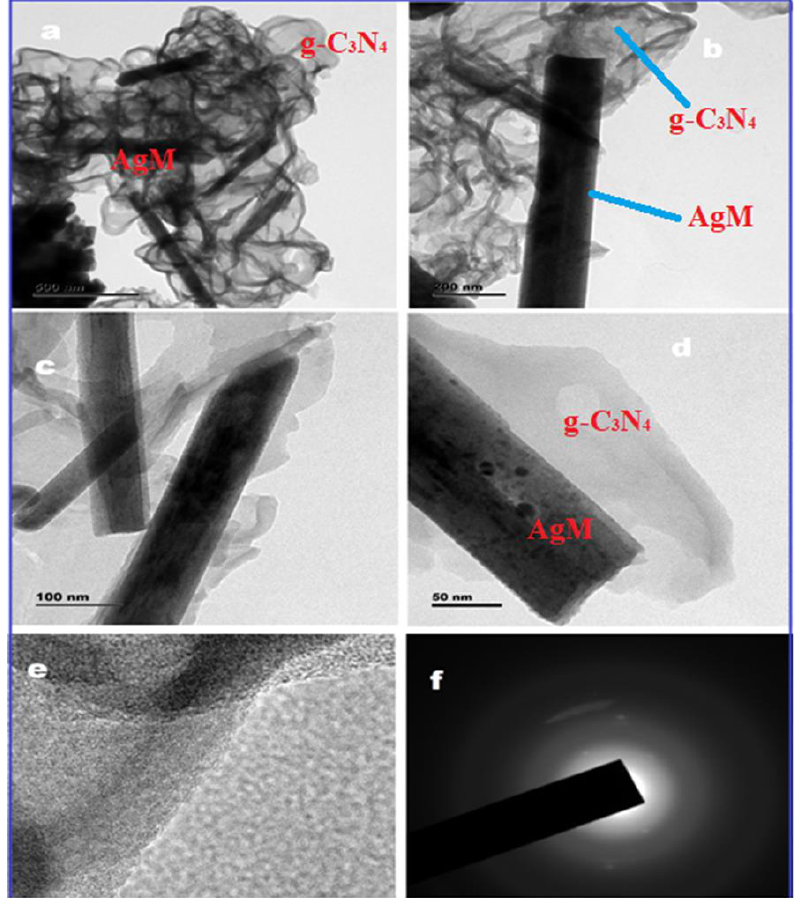
Figure 3. High resolution-transmission electron microscopy (HR-TEM)showing different magnifi- cation images of g-C 3 N 4 /AgM nanocomposites ( a – e ) and selected area electron diffraction (SAED) pattern of g-C 3 N 4 /AgM nanocomposite ( f ) (reproduced with permission from [89], copyright 2020 Elsevier B.V.).